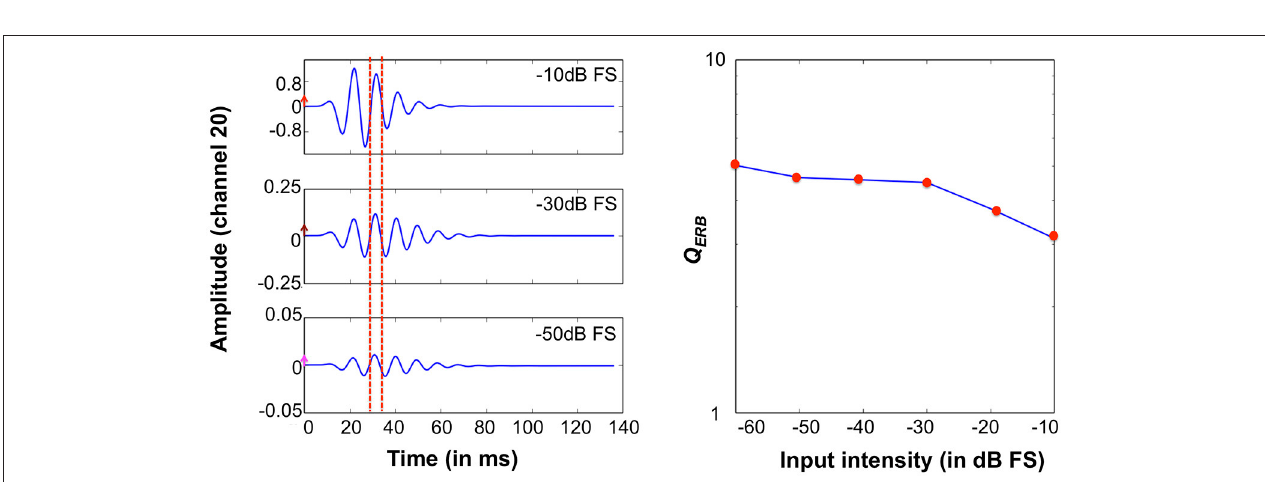
FIGURE 13 | System impulse responses at the 1kHz CF channel to -50 dB FS, -30 dB FS, -10 dB FS clicks. The arrows mark the amplitude of clicks. The red dashed lines mark two consecutive impulse response zero-crossings ( Left ). 1kHz Q ERB factors derived from impulse responses at relative intensities from -60 dB FS and -10 dB FS in steps of 10 dB FS ( Right